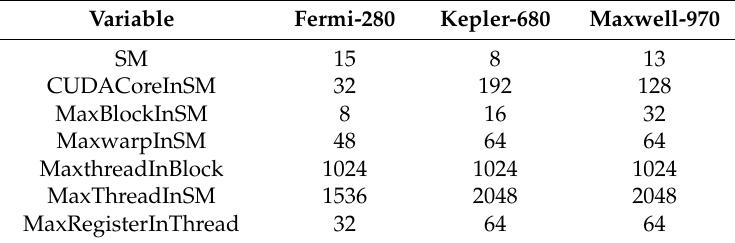
Table 3. Basic parameters according to